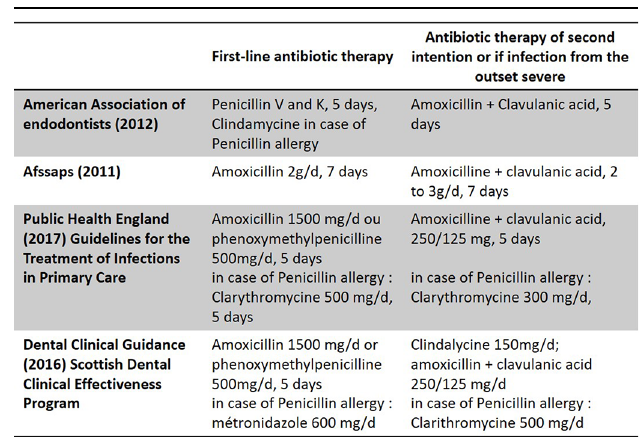
Table II. Synthesis of the main relevant international antibiotic prescription guidelines.